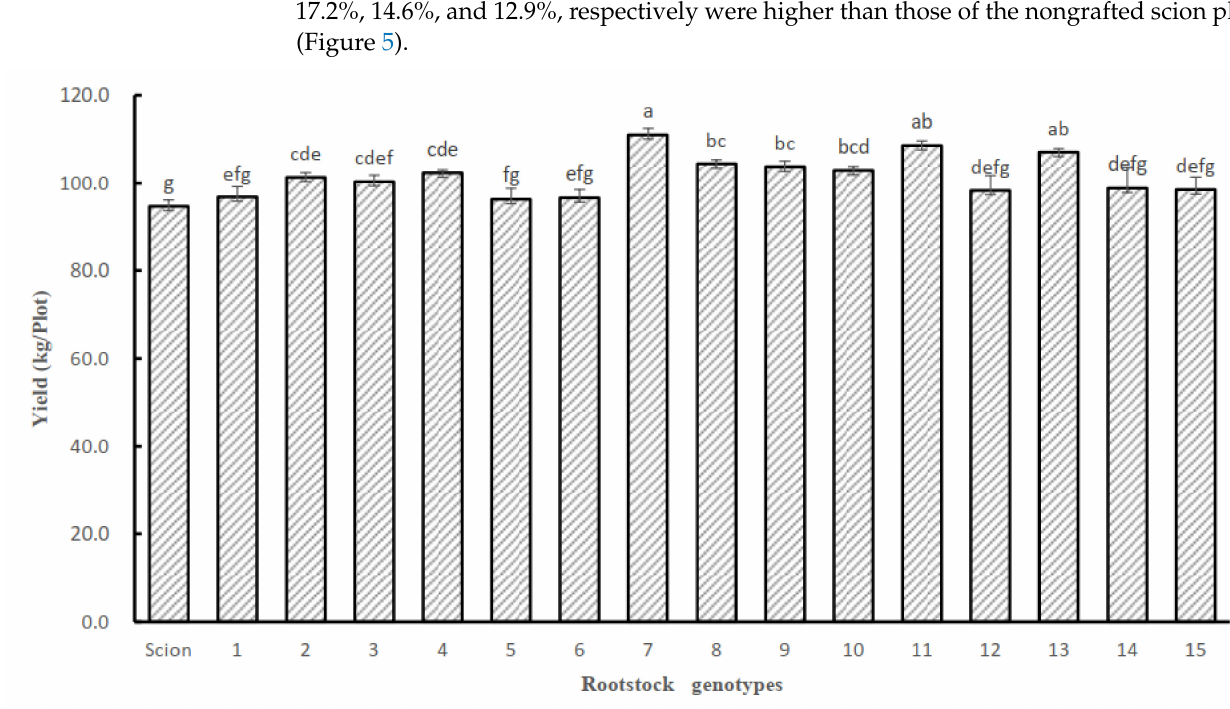
Figure 5. Fruit yield of grafted tomatoes with the 15 rootstock genotypes under greenhouse conditions. The average fruit yield of three replicate plots (35 plants per plot) of grafted tomato cultivars is presented; nongrafted scions were used as the control. The results are mean ± SEs. The means within each column followed by different letters are significantly different among grafted tomatoes with the 15 rootstock genotypes, according to Tukey’s test ( p <